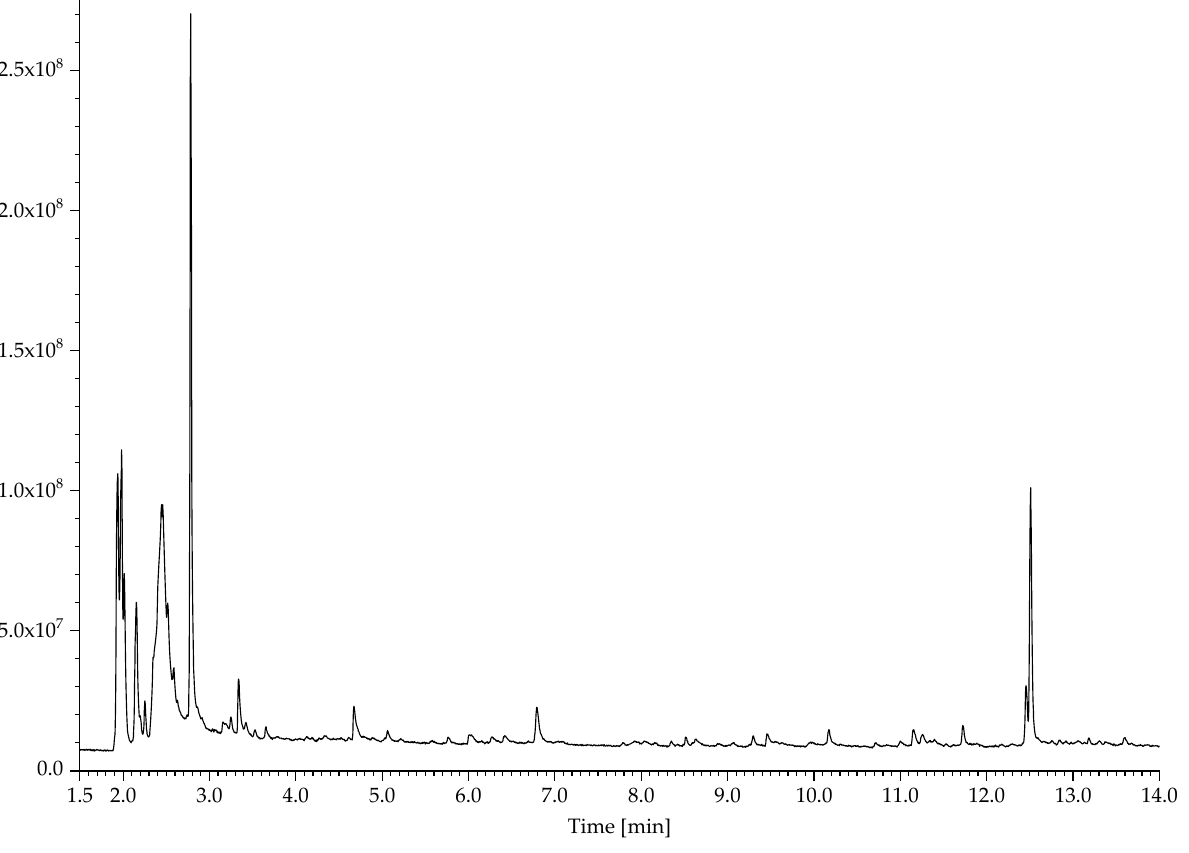
Figure 14. Pyrogram of sample 530 ( a ) and a zoomed ‐ in view of the same pyrogram ( b ).